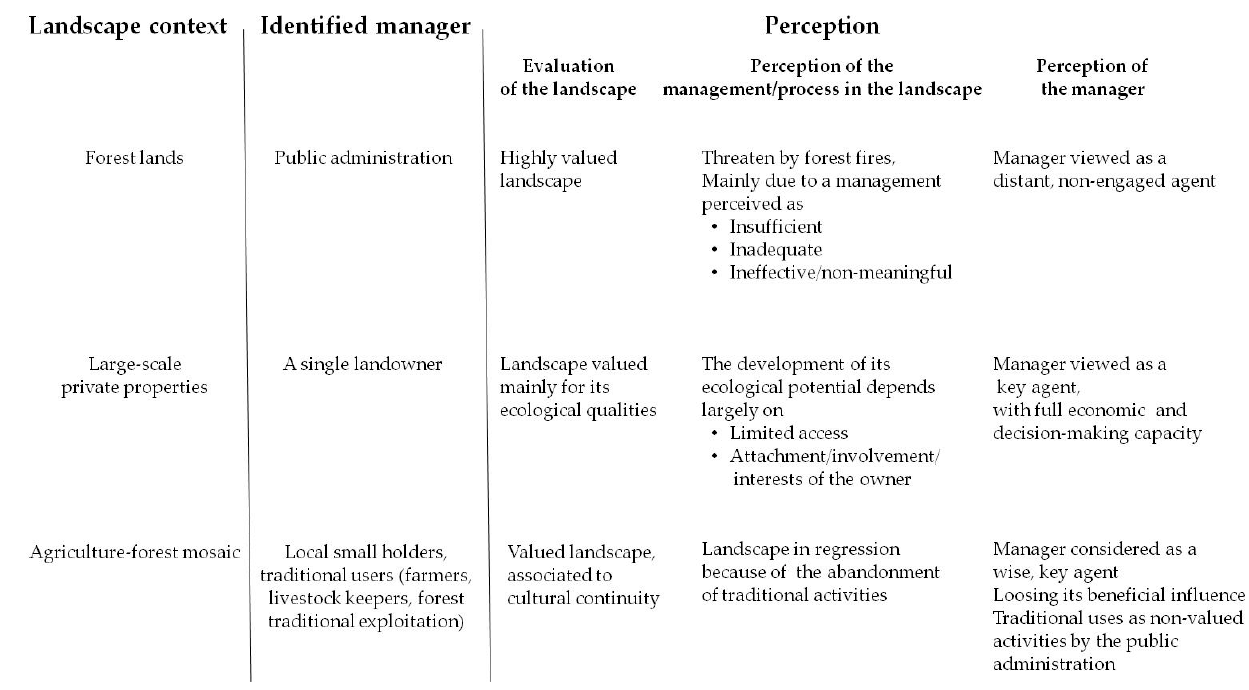
Figure 2. Comprehensive framework of the perception of the landscape management in the three different contexts.